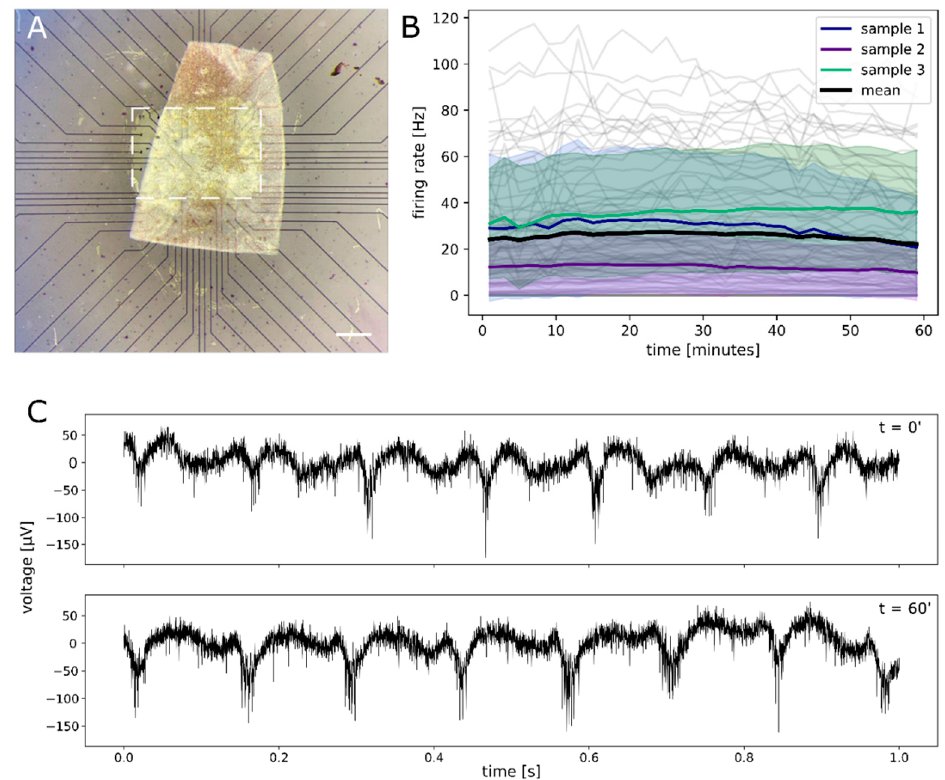
Figure 4. Functional assessment of mouse ex-vivo retina by electrophysiology via microelectrode array (MEA) recording. ( A ) Ex vivo retina sample placed on a glass MEA coated with D18/Y6. The white dashed rectangle indicated the window of the exposed MEA surface to ensure contact between the tissue and the electrodes to enable recording. Scale bar: 400 µ m. ( B ) Firing rate during a continuous 1 h recording. The plot shows the average firing rate (FR) values for retinal ganglion cells in 3 different retina samples and the average of the 3 samples (black line—mean). Small gray line indicates FRs on single electrodes, colored areas indicate the standard deviation of the mean FR. ( C ) Characteristic photoreceptor-degenerated retina rhythmic activity (retinal waves) recorded from the same electrode at the start (t = 0 ′ ) and the end (t = 60 ′ ) of the one-hour continuous recording.